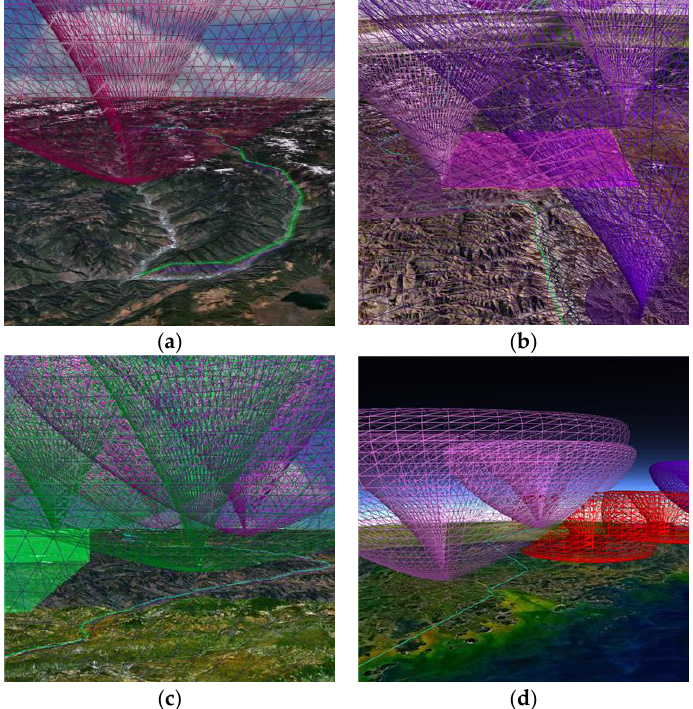
Figure 25. Low altitude penetration routes using MACO-pl of different cases. ( a ) Case 1 ; ( b ) Case 2 ; ( c ) Case 4 ; ( d ) Case 5 .